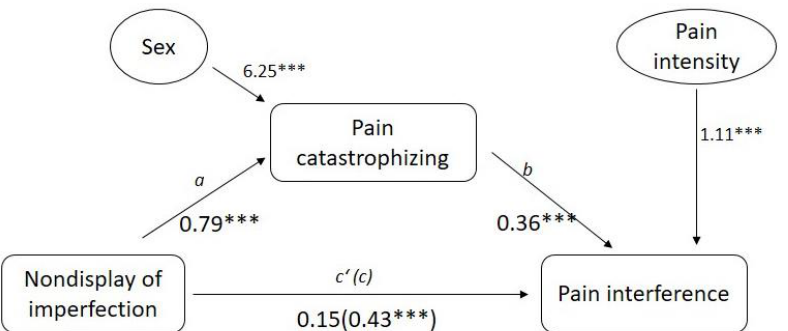
Figure 3. Mediation effect of pain catastrophizing on the association between nondisplay of imper- fection and pain interference. Note: *** p < 0.001.